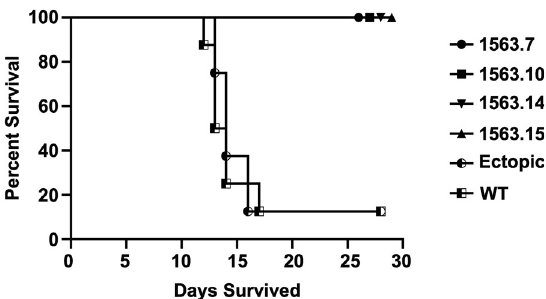
Fig 4. Infection of mice with C . posadasii Δ ryp1 . Survival results for C57BL/6 mice (N = 8 mice/group) infected intranasally with four independent Δ ryp1 strains, 1563.7 (circle), 1563.10 (square), 1563.14 (inverted triangle) and 1563.15 (triangle); one strain with the ryp1 deletion cassette integrated ectopically into WT, 1563.1 (half-filled circle); and WT (half-filled square). The Δ ryp1 strains were infected at between 525 and 1133 viable arthroconidia, while 50 viable arthroconidia of the ectopic stain and WT were